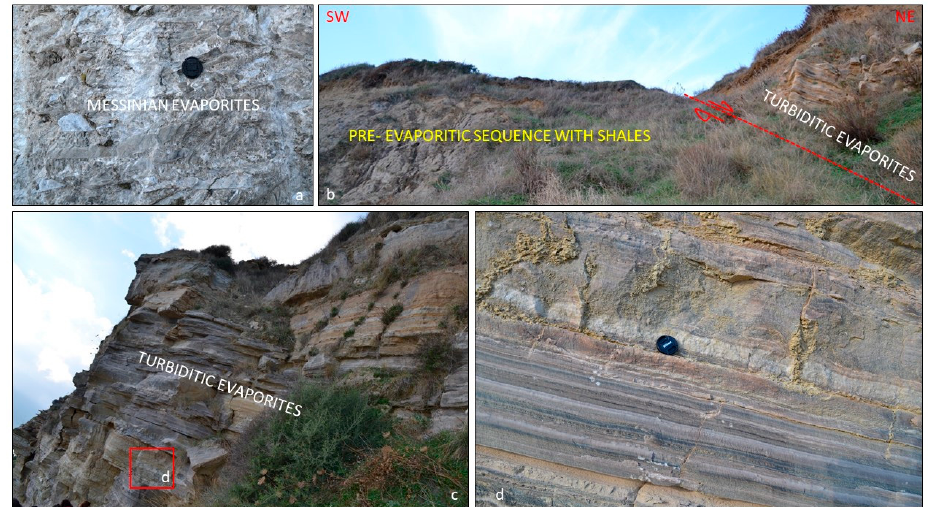
Figure 3. ( a ) Messinian evaporites very close to Ag. Sostis section. ( b ) Part of Ag. Sostis section with the fault-controlled contact between pre-evaporitic sections with the turbiditic evaporites. ( c ) The turbiditic evaporites and ( d ) from close the turbidites mostly with Tb Bouma sub-interval.